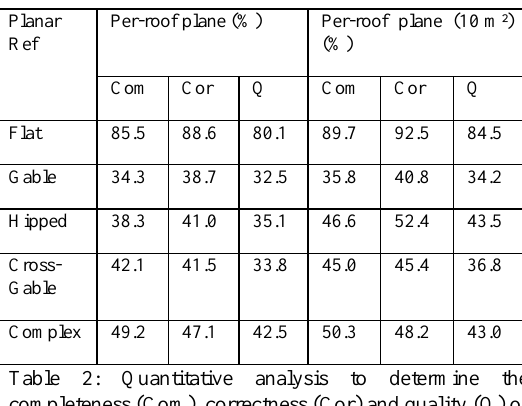
Table 1: Quantitative analysis for the location and number of the extracted corner points